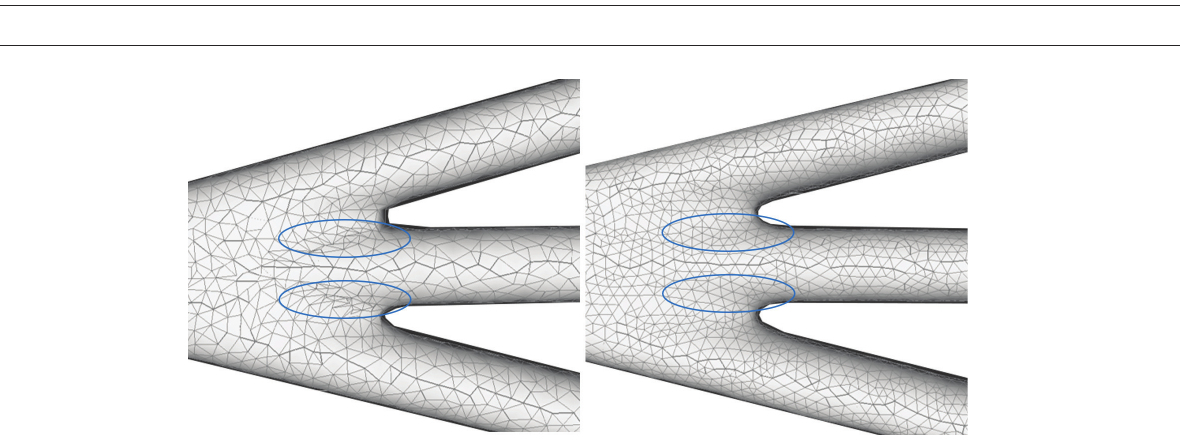
FIGURE7 Quasi-uniform remeshing. The mesh without vertex optimization (left) includes many low-quality triangles especially near branching regions, as highlighted by the blue color. Our approach adjusts the unsatisfactory triangles by iterative remeshing optimization and generates quasi-uniform meshes (right)